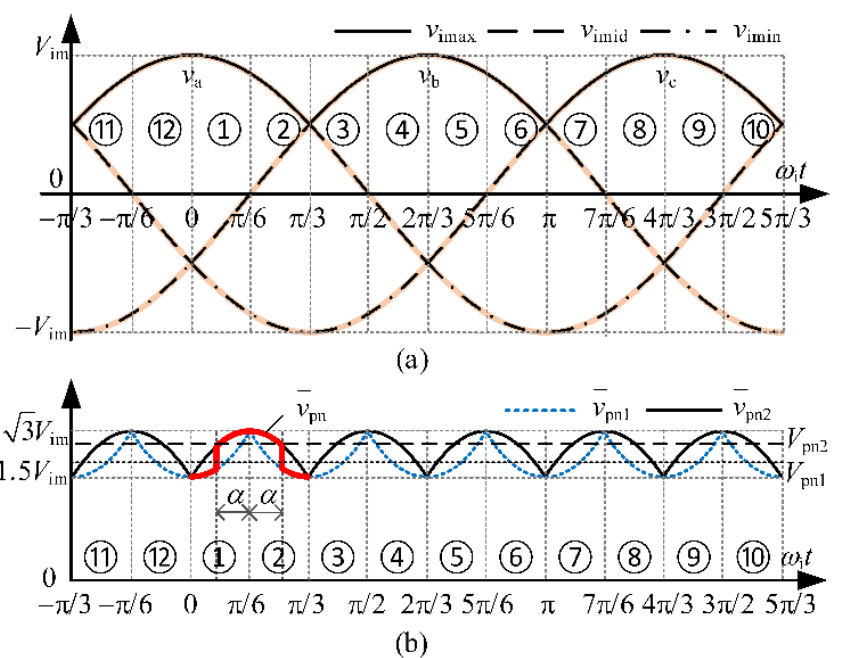
v waveform. ( a ) Rectifier pn